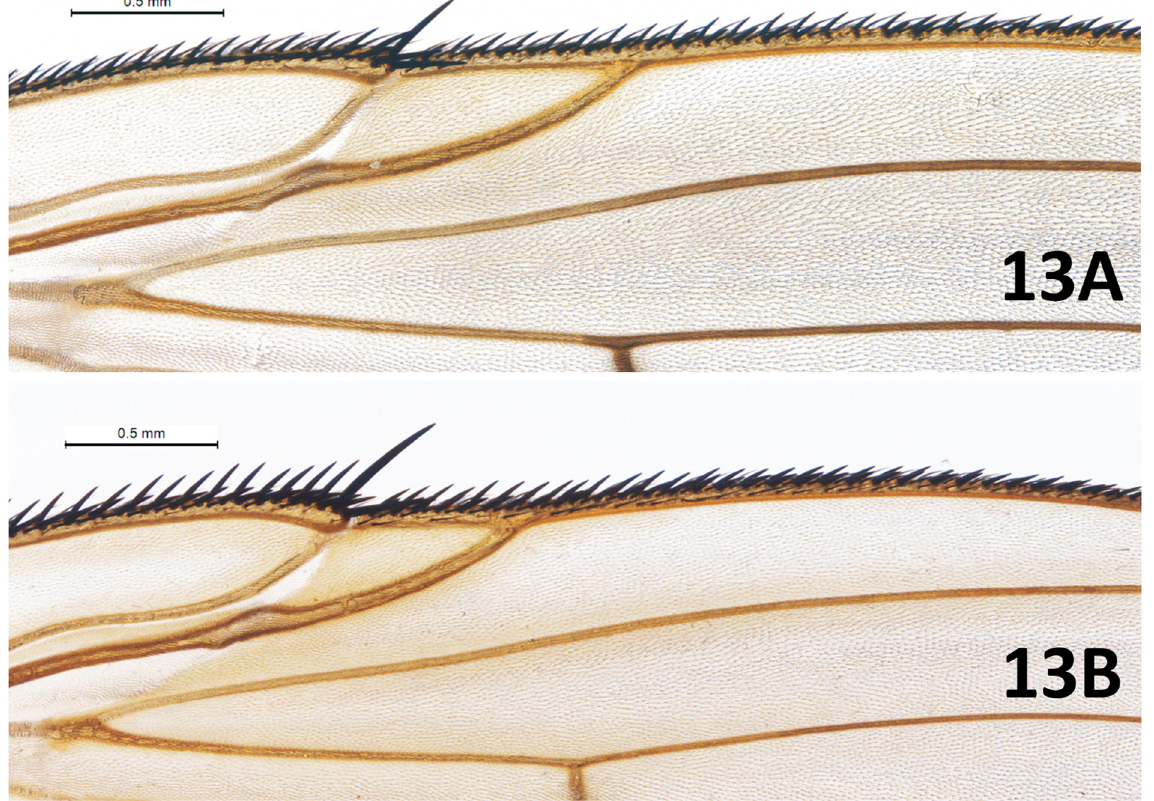
Fig. 13. ♀♀ of Helina Robineau-Desvoidy, 1830. A . H . depuncta (Fallén, 1825), detail of wing showing CS1‒3, dorsal view. B . H . allotalla (Meigen, 1830), detail of wing showing CS1‒3, dorsal